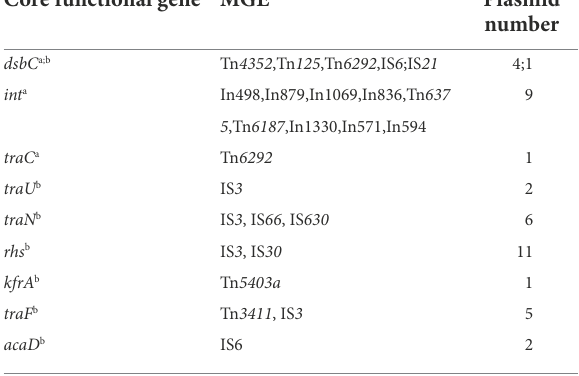
TABLE 3 Evolutionary events, including gene interruption and gene carriages, by mobile genetic elements. Core functional gene MGE